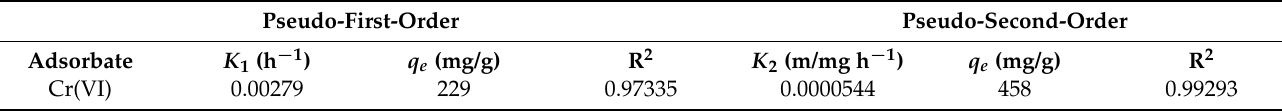
Table 2. The parameters of the kinetic models for removal of Cr by